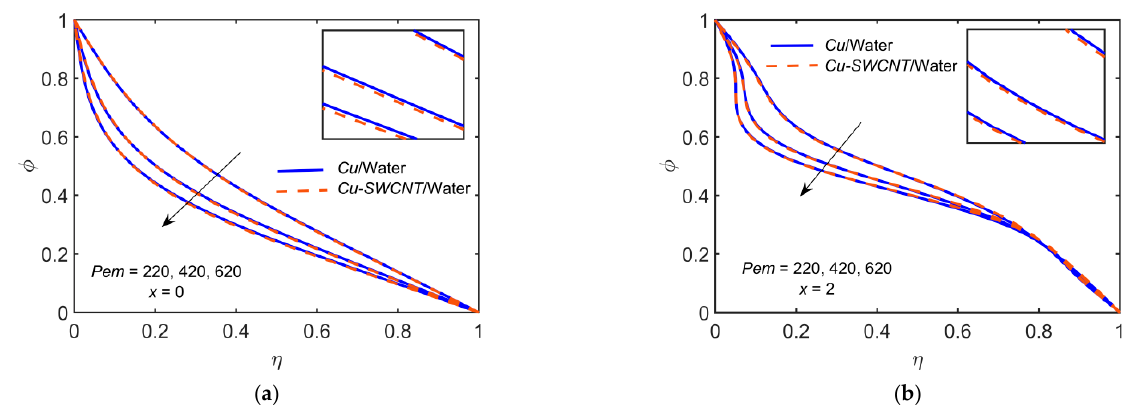
Figure 12. The 𝜑 profile at ( a ) 𝑥 = 0 and ( b ) 𝑥 = 2 for distinct values of 𝑃𝑒𝑚 . Figure 13 depicts the impact of Cu-based NF and Cu-SWCNT-based HNF for the Soret number 𝑆𝑟 = 1, 1.5, 2, 2.5 on (a) the concentration (𝜑) profile at 𝑥 = 0 , and (b) the concentration (𝜑) profile at 𝑥 = 2 . The figure shows that as 𝑆𝑟 estimations intensify, the concentration profile escalates. The HNF concentration profile is slightly higher than that of the NF.